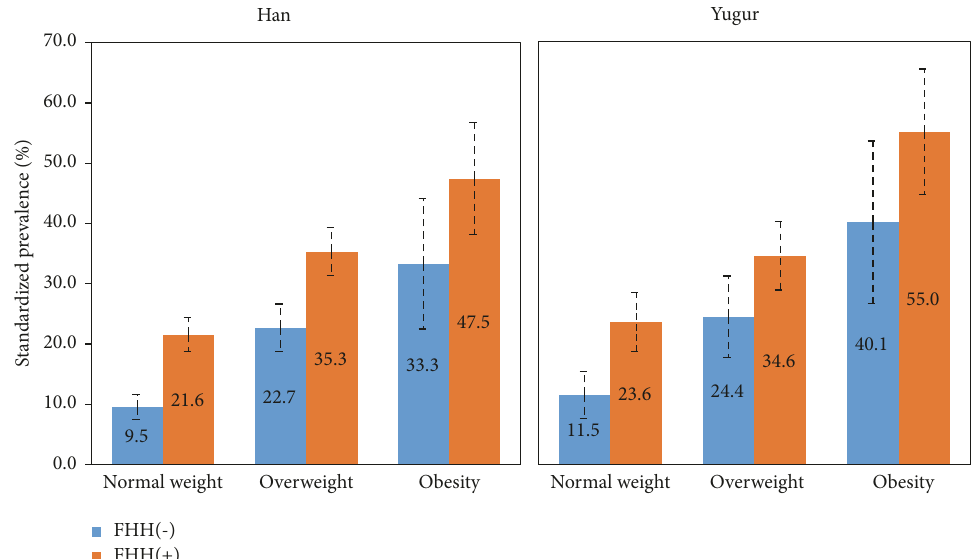
Figure 1: Standardized prevalenceof hypertension according to categoriesof BMI and FHH in Han and Yugurpeople in China. Prevalenceof hypertension was age- and gender-standardized based on 2010 China census population data of Gansu province using direct standardization method. Bars represent proportion and error bars (95% CI ). BMI: body mass index, FHH: family history of hypertension.